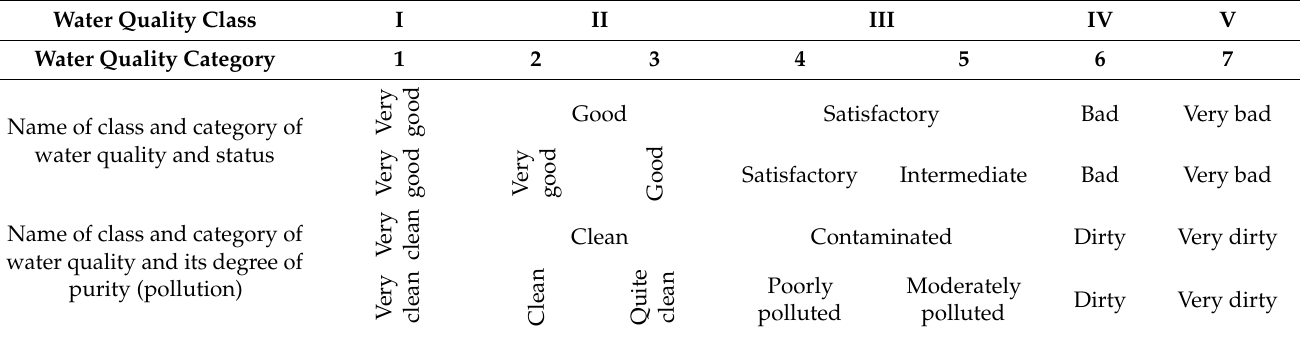
Table 2. Assessment of surface water quality in